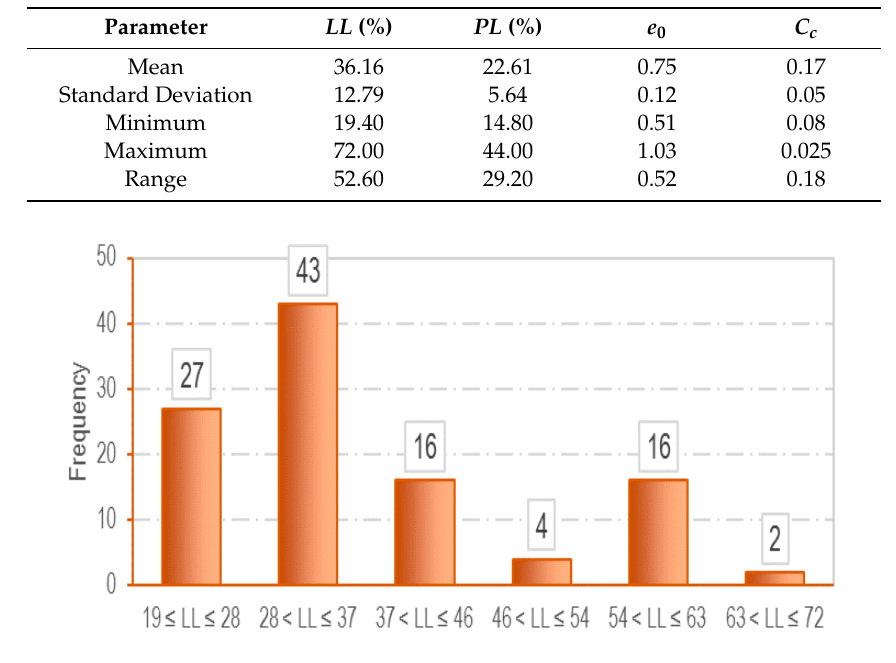
Table 1. Descriptive statistics for input and output parameters used in the GEP-based developed model. LL: liquid limit; PL: plastic limit.